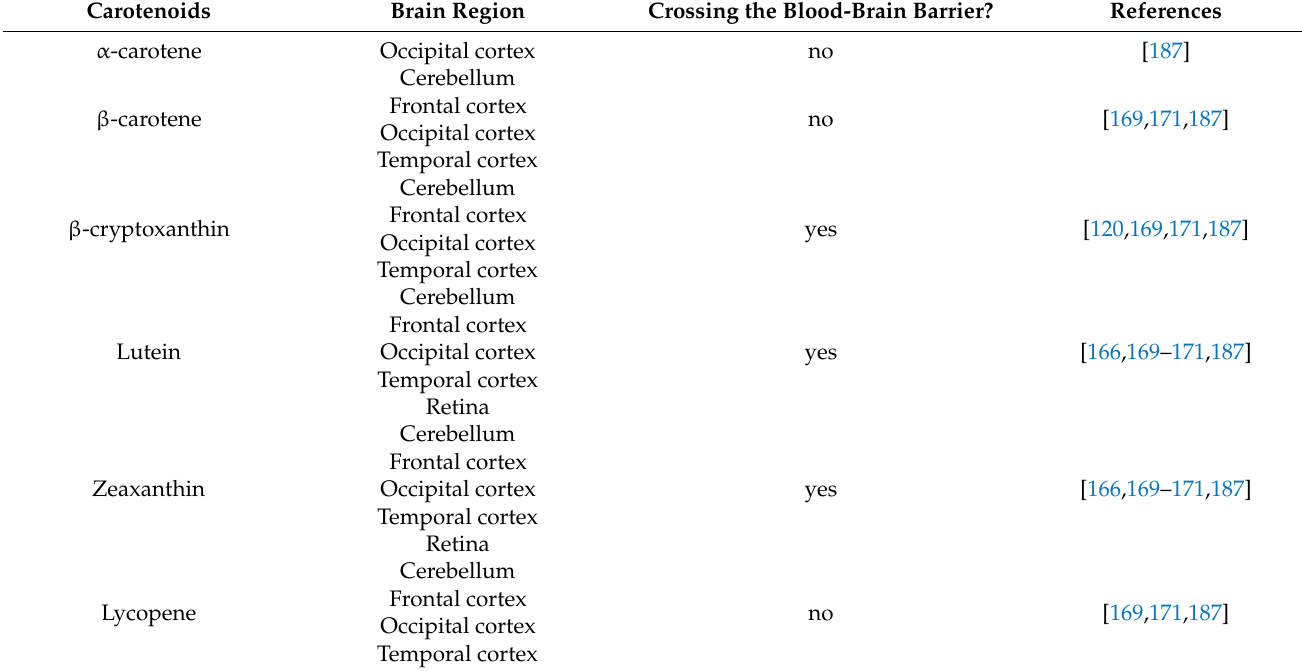
Table 1. Localization of certain carotenoids in the brain. Source: Own elaboration based on the indicated